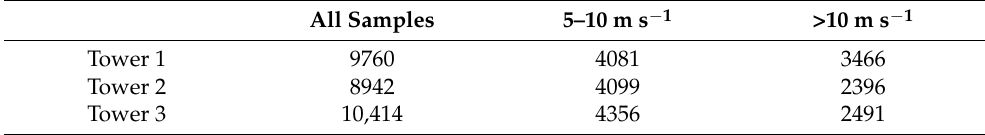
Table 2. Summary of the number of samples.